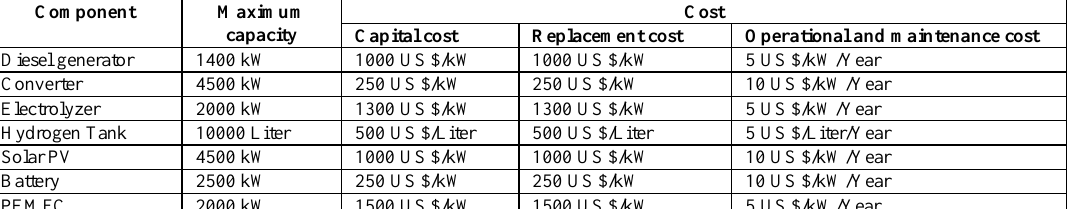
Table 1. Techno-economical details of the HPS components.